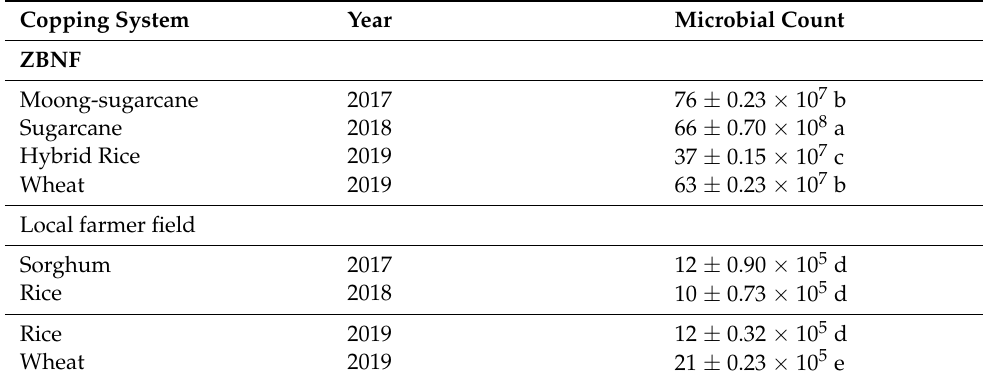
Table 2. Comparison of microbial load in ZBNF farm and farmer’s field. Different letters indicate the significance difference at a p